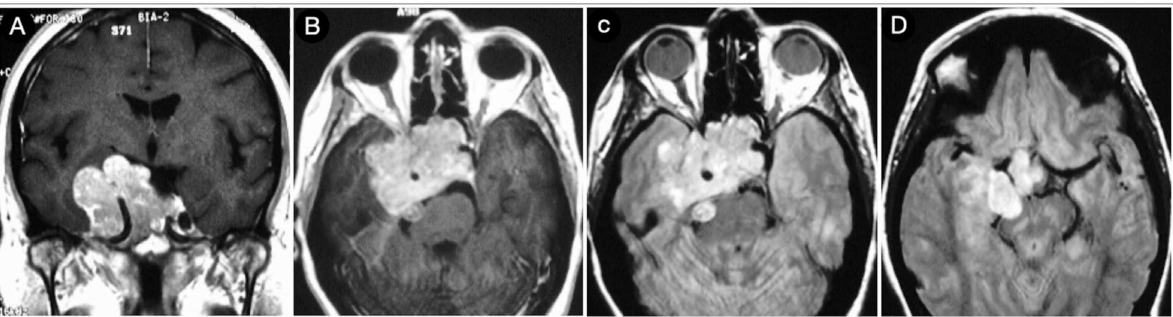
Figure 19. Preoperative coronal ( A ) and axial ( B – D ) T1-weighted contrast-enhanced MRI. Scale bar: 5 cm.